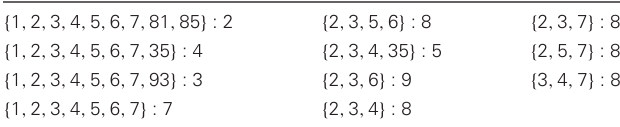
Table 3 | Closed frequent neuron sets found in data with an injected assembly with seven neurons and seven coincidences, after filtering with surrogate data; support/coincidences after the colon.